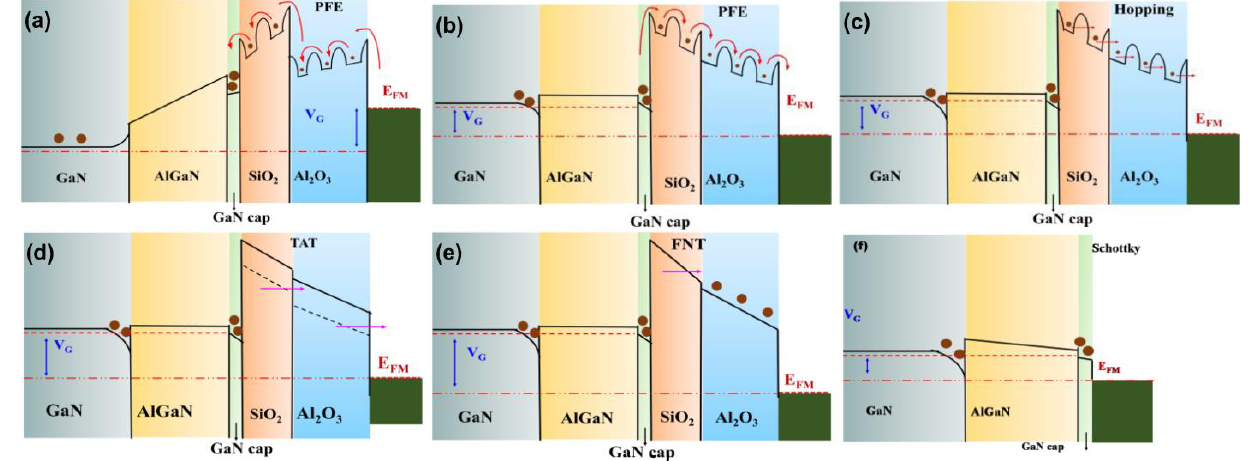
Figure 8. Conduction band edge diagram of Al 2 O 3 /SiO 2 MOS–HEMT ( a – c ) before and ( d ), ( e ) after PGA treatment, and ( f ) conventional HEMT under different operating regions and showing the dominant conduction mechanism at each region.